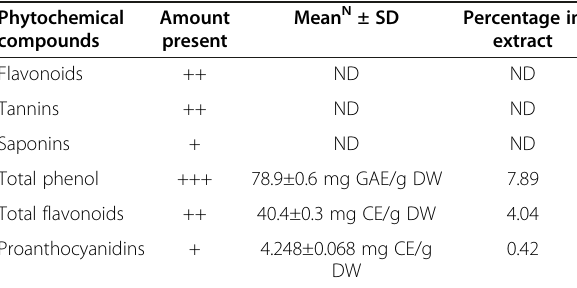
Table 1 Phytochemical compounds of Pluchea indica root aqueous extract.